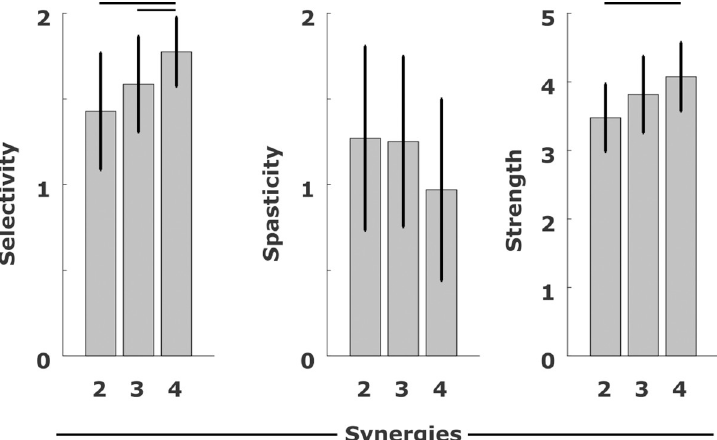
Fig 1. Selectivity, spasticity and strength scores. Scores for Selectivity, Spasticity and Strength from the subjects, grouped according to the number of synergies. For the Selectivity score, 2 is the maximum selectivity. For the Spasticity score, 0 means no spasticity and 2 is the maximum. For the Strength score, 5 is the maximum. Black lines indicates significant differences between two quantities (p < 0.05).